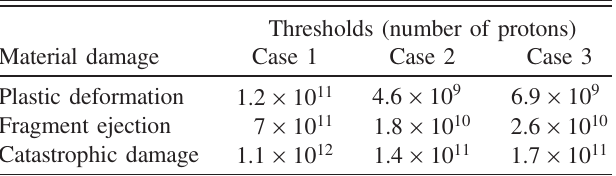
TABLE IV. Damage limits calculated for the tungsten colli- mator jaw for the three cases discussed in the